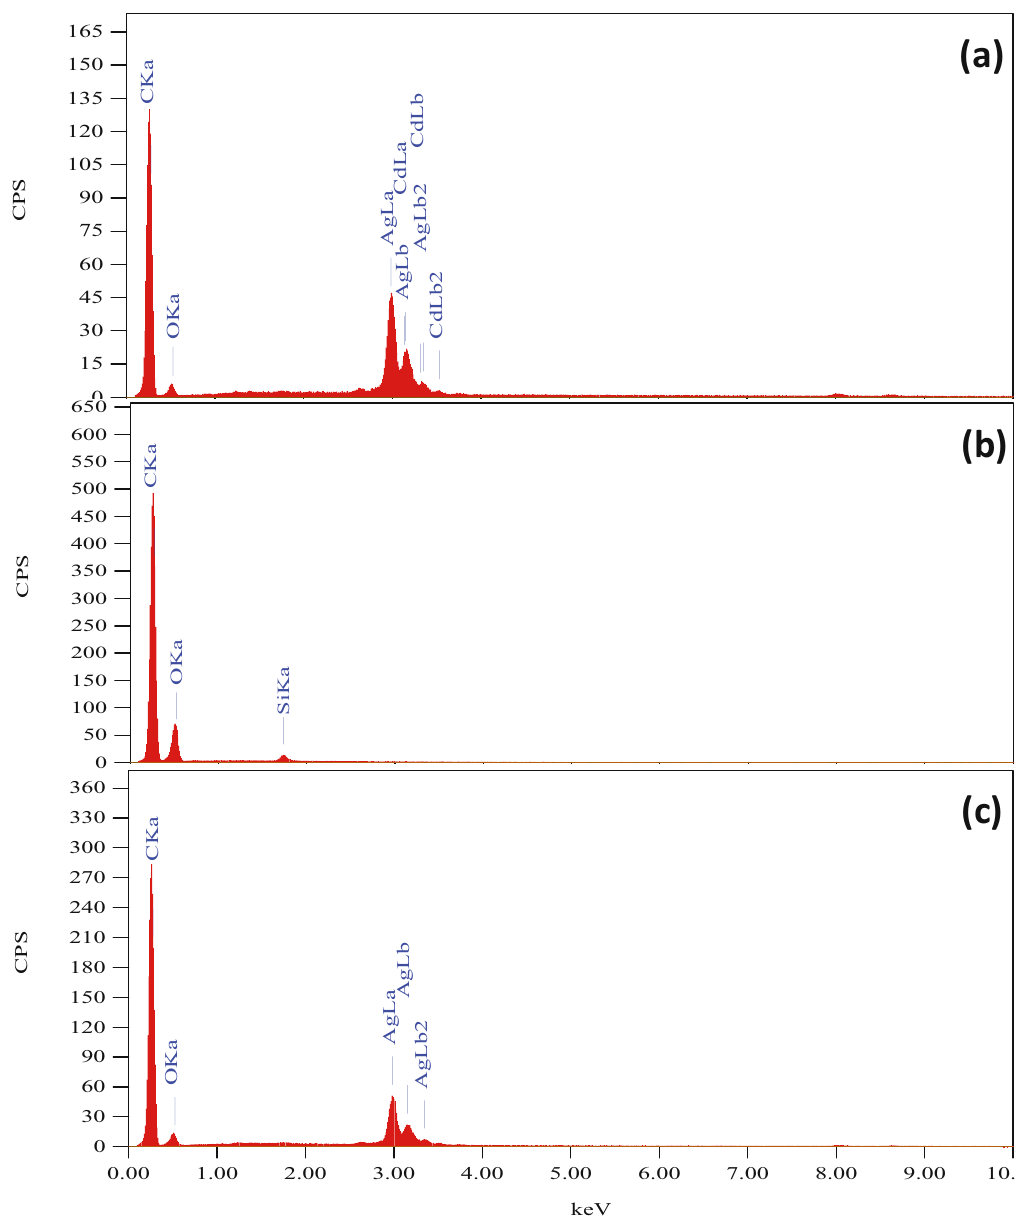
Figure 4: EDX of ( a ) AgStNPs, ( b ) bare organic monolith, and ( c ) AgStNP – methacrylate polymeric